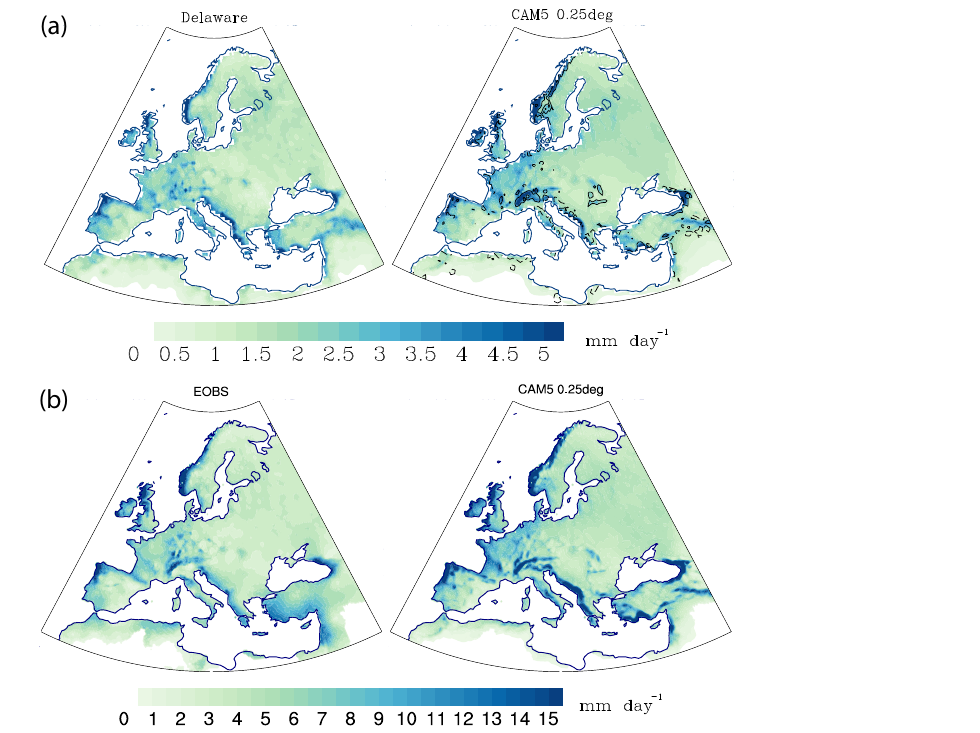
Figure 3. (a) Time-mean average of DJF monthly means of precipitation ratio (mmday − 1 ), averaged over the period 1979–2005, in obser- vations (Delaware, 0.5 ◦ resolution), and the CAM5_0.25 model, smoothed to 0.5 ◦ × 0.5 ◦ horizontal resolution; (b) DJF daily precipitation 90th percentiles (mmday − 1 ), averaged over the period 1980–2005 in observations (E-OBS, 0.25 ◦ resolution) and the CAM5_0.25